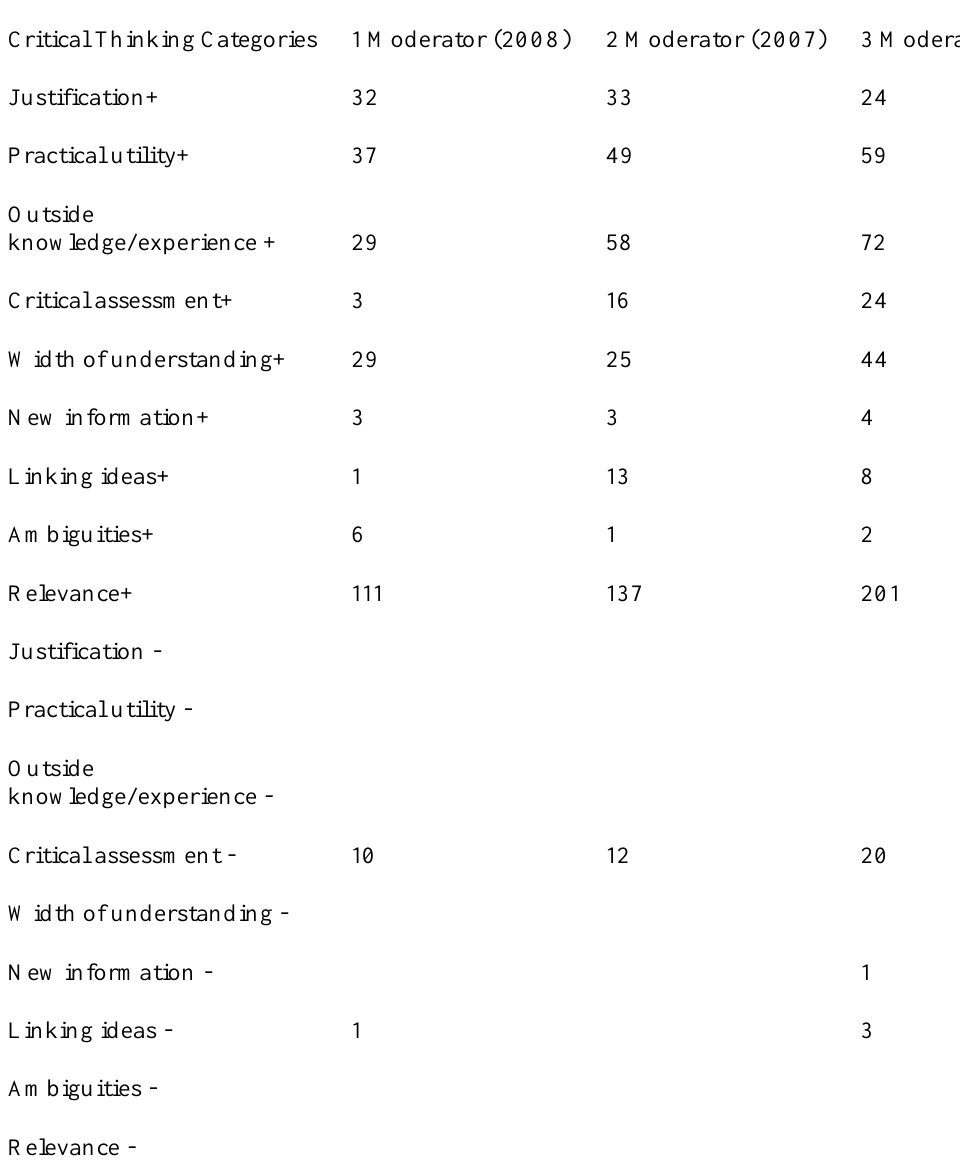
Critical Thinking Occurrences with One, Two, and Three Student Moderators